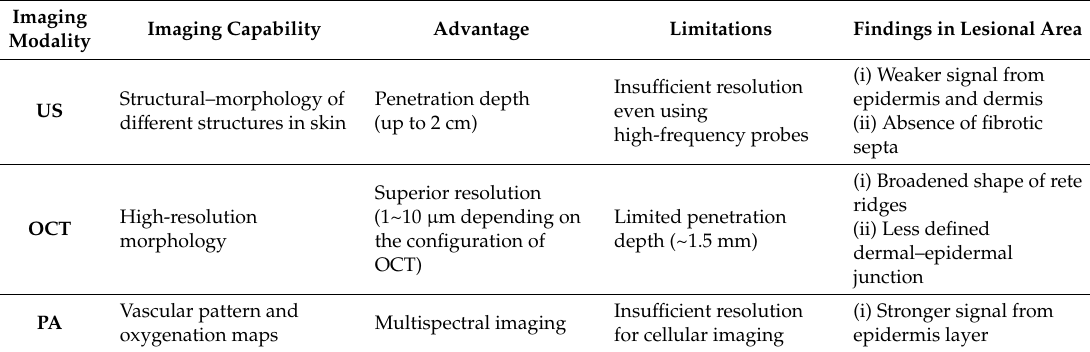
Table 2. Advantages and disadvantages of US, OCT, and PA imaging for melanoma